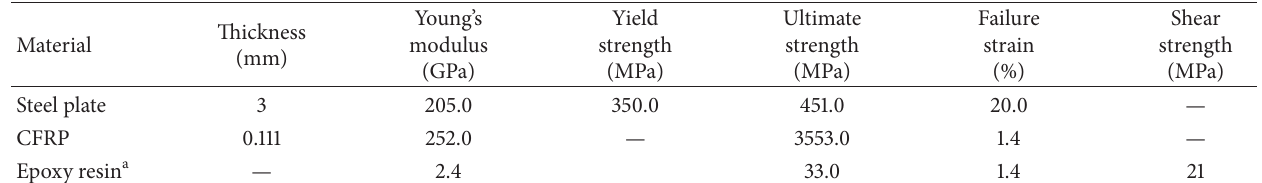
Table 1: Material properties.